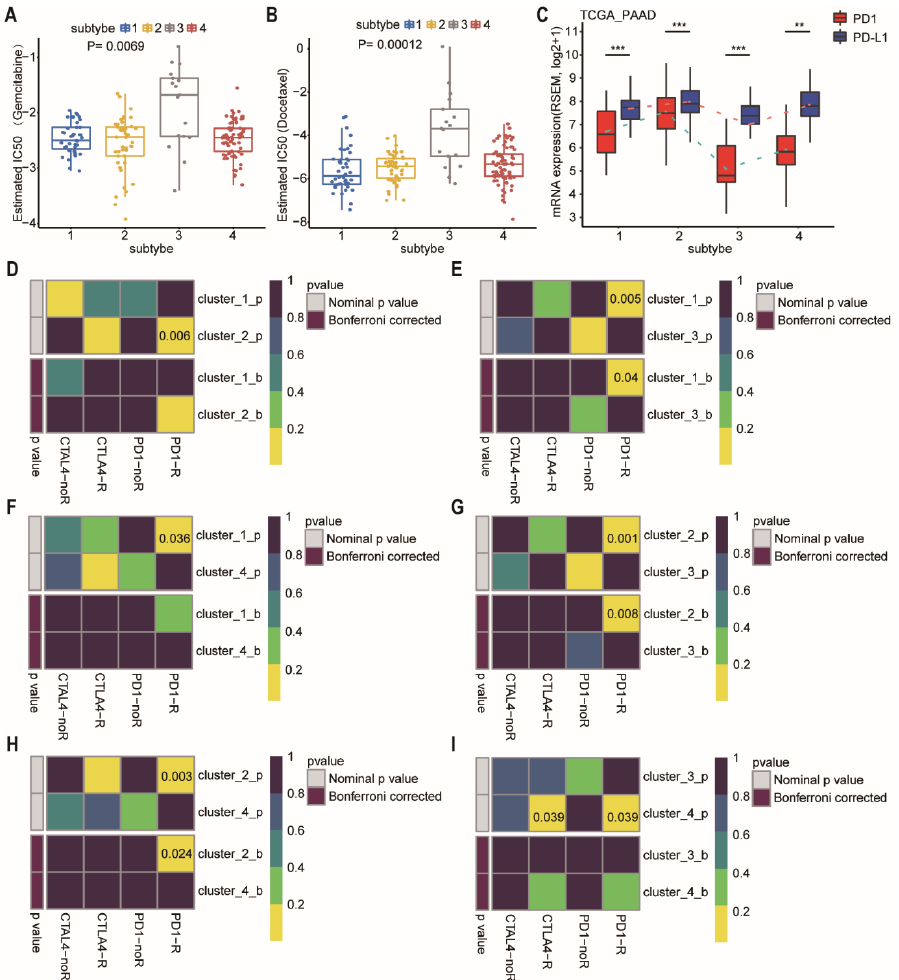
Figure 7. Differences in sensitivity of network-based subtypes to chemotherapy and immunotherapy. ( A , B ) The box plots showed the estimated IC50 for gemcitabine ( A ), and docetaxel ( B ) among network ‐ based subtypes. The Kruskal–Wallis test was performed to calculate the p ‐ value. ( C ) Ex ‐ pression level of PD ‐ 1 and PD ‐ L1 among network ‐ based subtypes of PDAC patients from TCGA